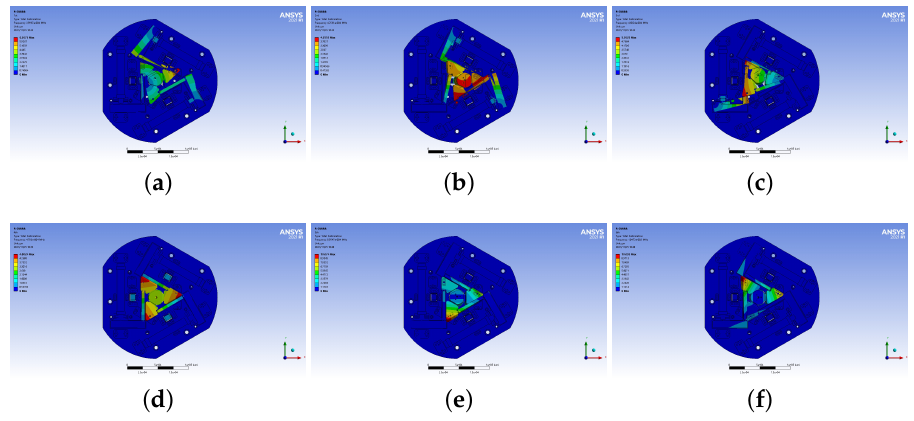
Figure 14. Natural frequencies of the 6-RRRR CPM. ( a ) 1st, 4.00 × 10 2 Hz; ( b ) 2nd, 4.26 × 10 2 Hz; ( c ) 3rd, 4.60 × 10 2 Hz; ( d ) 4th, 4.78 × 10 2 Hz; ( e ) 5th, 8.95 × 10 2 Hz; ( f ) 6th, 1.05 × 10 3 Hz.